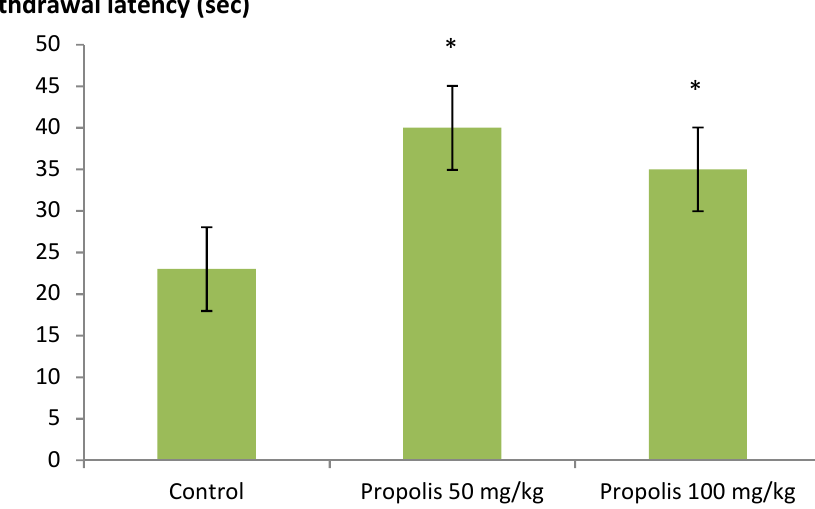
Figure 1. Antinociceptive effect of green Brazilian propolis alcohol extract (P50 and P100) in the infrared test in the rats. The values expressed are mean ± SEM, ( n = 6).* p < 0.05: significantly different for treated (P50 and P100) compared to the control groups as determined by ANOVA analysis followed by multiple comparison post hoc test.